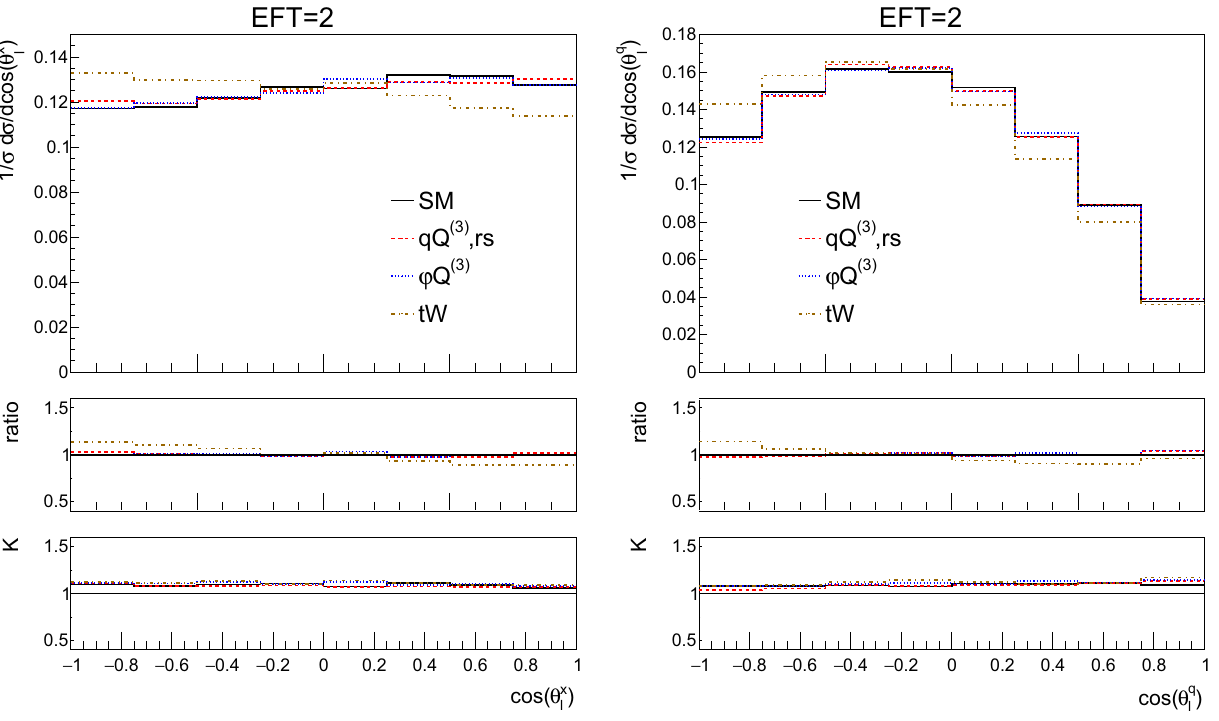
Fig. 13 The NLO distributions of the top polarisation angle (left) and W helicity (right) for the SM and the three effective operators of interest for the couplings values of Table 2. The ratio shown in the first inset is defined as the effect of the operator over the SM, the second inset shows the K